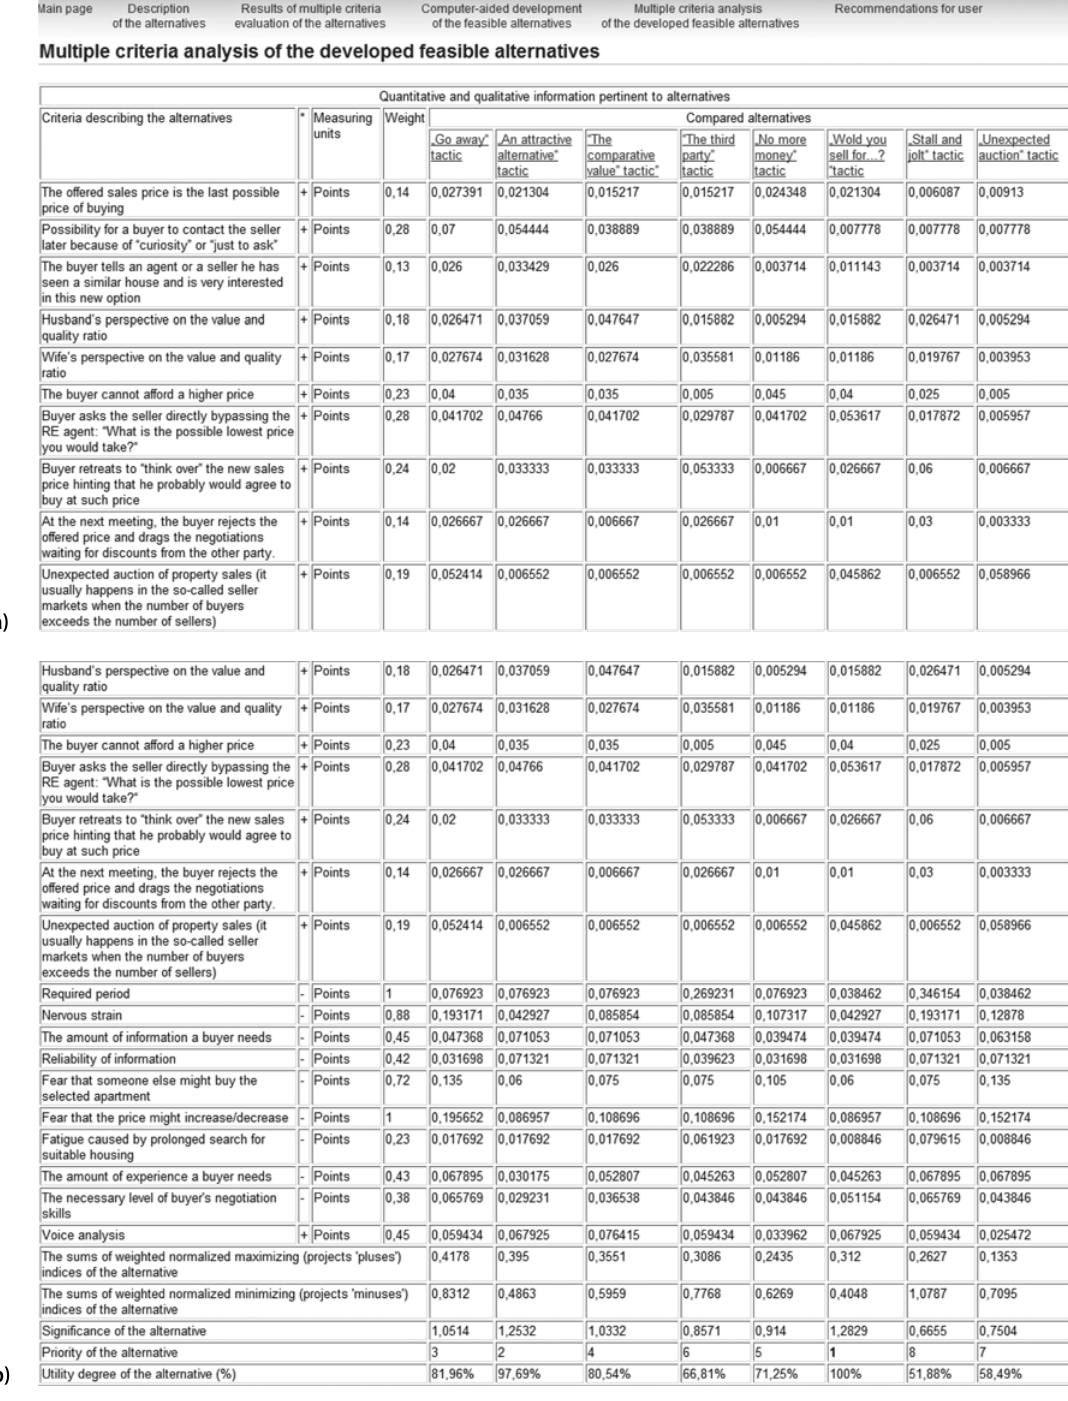
Figure 7. Fragments of multiple criteria analysis of the feasible alternatives (negotiation tactics): a) – top part of the table and b) – bottom part of the